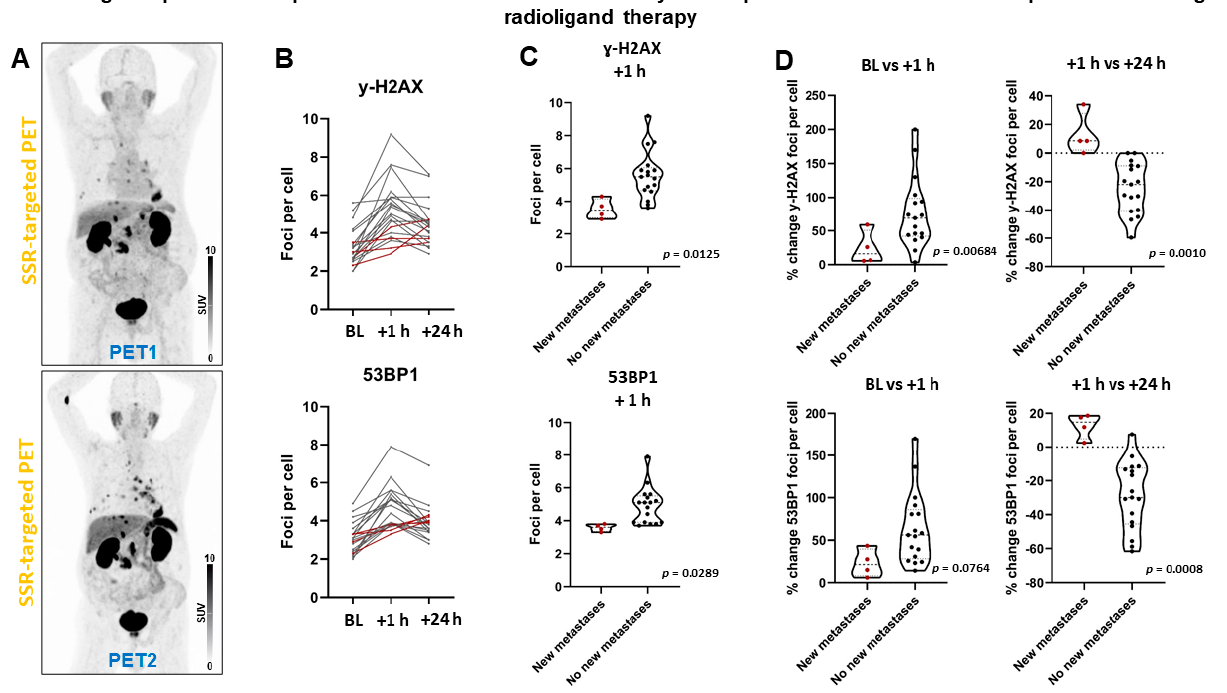
Figure 6. DNA damage response and early development of new metastases in patients receiving PRRT. ( A ) Somatostatin receptor (SSR)-targeted maximum-intensity projection PET image before (PET1) and after (PET2) PRRT in a patient with early development of new thoracic metastases. ( B ) Graphical illustration of individual DSB foci kinetics. Patients with early development of new metastases (dotted red lines) demonstrated a distinct kinetic pattern with absent foci resolution between +1 and +24 h, and low foci increase between baseline and +1 h. ( C ) Patients with early development of new metastases had significantly lower number of DDR foci at +1 h. ( D ) Patients with early development of new metastases did not show resolution of DDR foci between +1 and +24 h.